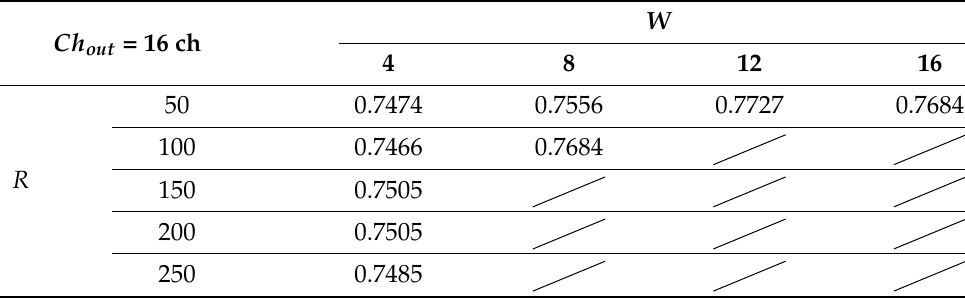
Table 12. Accuracy of parameter search at Ch out = 16